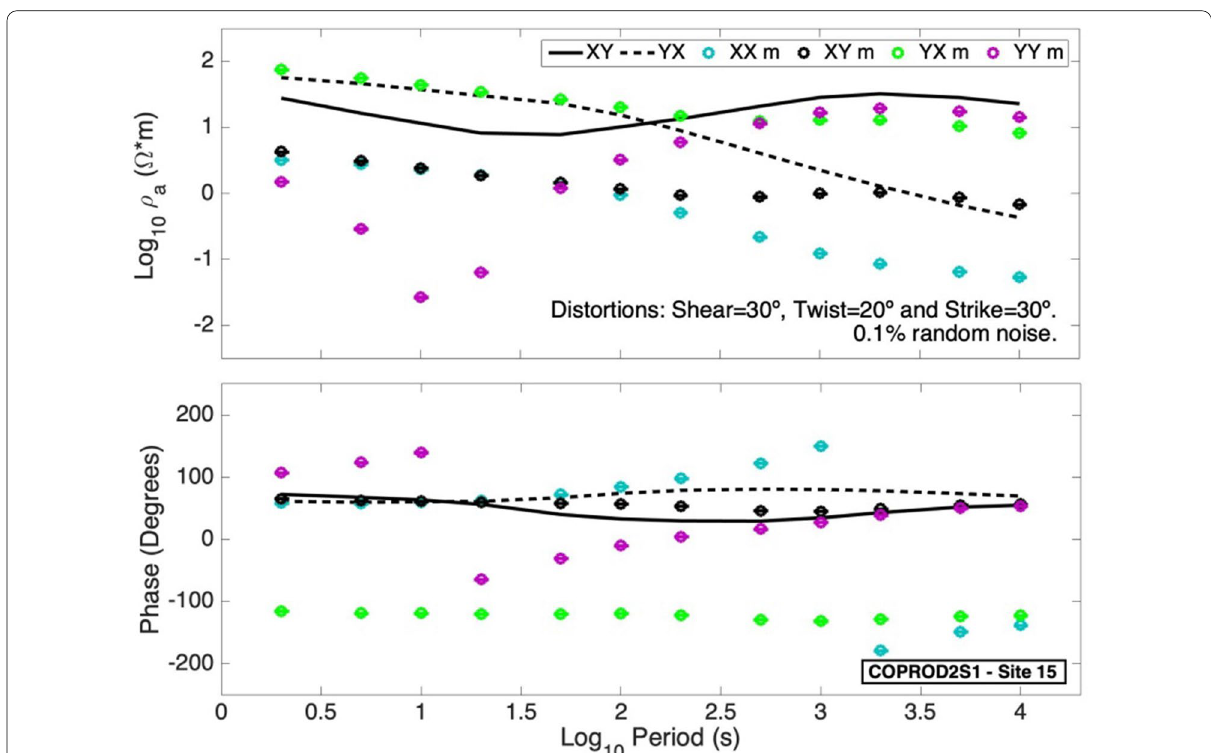
Fig. 1 The continuous and dashed lines correspond to synthetic data for site 15 of the COPROD2S1 dataset proposed by Varentsov (1998). The data are provided as apparent resistivities and phases for 12 periods. The colored dots represent the distorted values assuming twist and strike 30°. A small random error of 0.1% of the xy and yx impedances was added to the distorted =